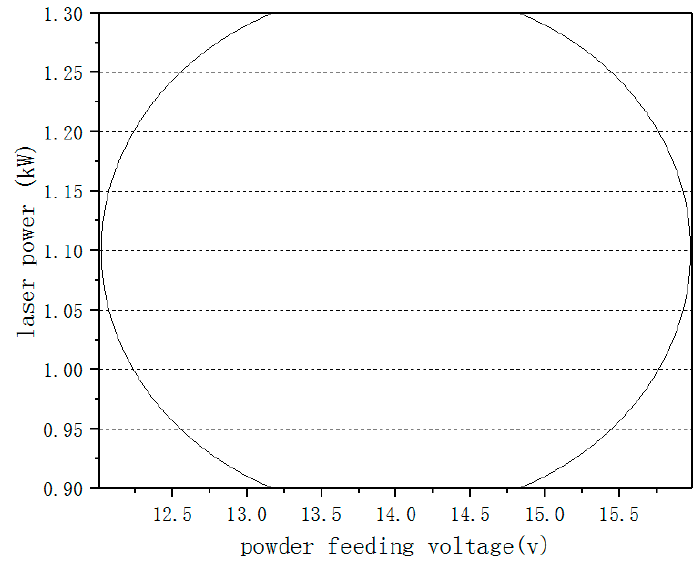
Figure 4. Range of laser power and powder feeding voltage.